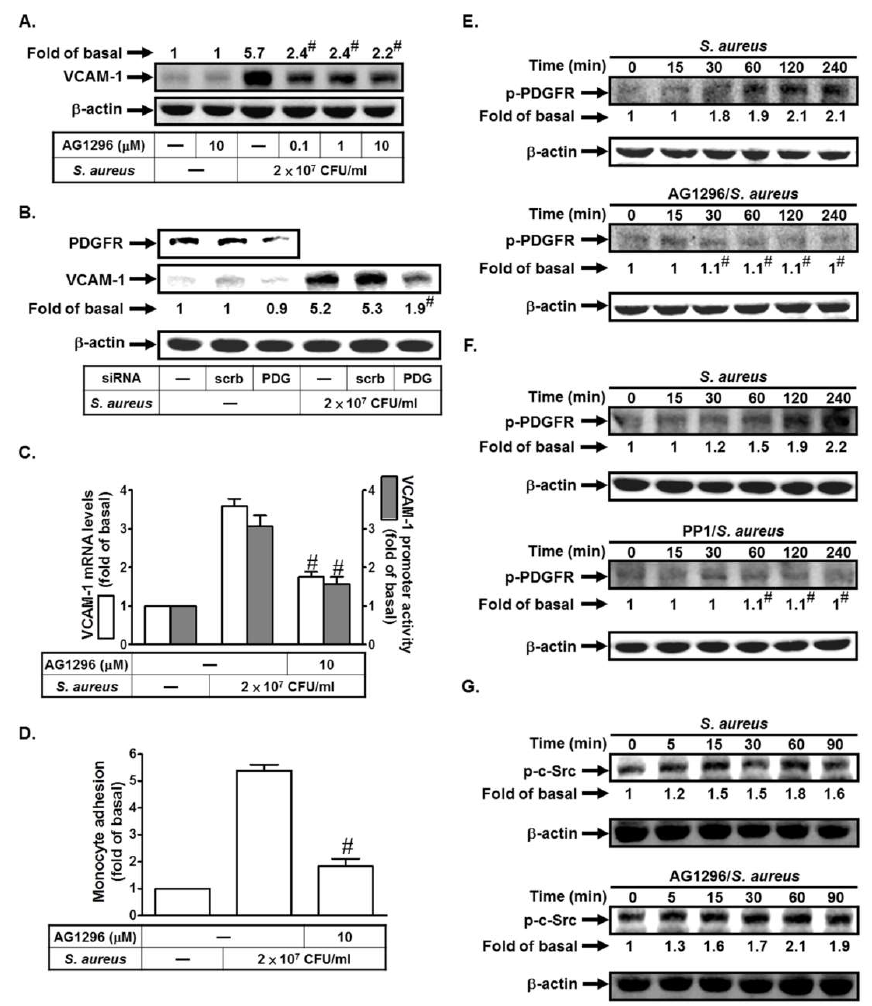
Figure 2. S. aureus induces VCAM-1 expression in HPAEpiCs via PDGFR. ( A ) Cells were pretreated with AG1296 for 1 h, and then treated with S. aureus for 24 h. The protein levels of VCAM-1 were determined. ( B ) Cells were transfected with scrambled or PDGFR siRNA, and then incubated with S. aureus for 24 h. The protein levels of PDGFR and VCAM-1 were determined. ( C , D ) Cells were pretreated with AG1296 for 1 h, and then treated with S. aureus for 4, 6, or 24 h. The mRNA levels and promoter activity of VCAM-1 were determined ( C ). The THP-1 cells adherence was measured ( D ). ( E , F ) Cells were pretreated without or with AG1296 or PP1 for 1 h, and then incubated with S. aureus for the indicated times. The expression of phospho-PDGFR was determined by Western blot. ( G ) Cells were pretreated without or with AG1296 for 1 h, and then incubated with S. aureus for the indicated times. The expression of phospho-c-Src was determined by Western blot. n = 3–4, # p < 0.01, as compared with the cells exposed to S. aureus alone ( A , C , D,E,F ) or scrambled siRNA + S. aureus (B).